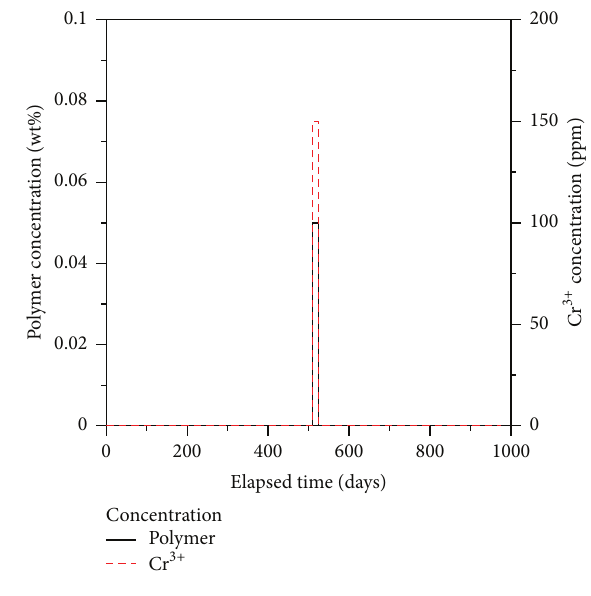
Figure 2: Injection history of concentrations for polymer and Cr 3+ . Table 2: Variables for single-scale correlation.